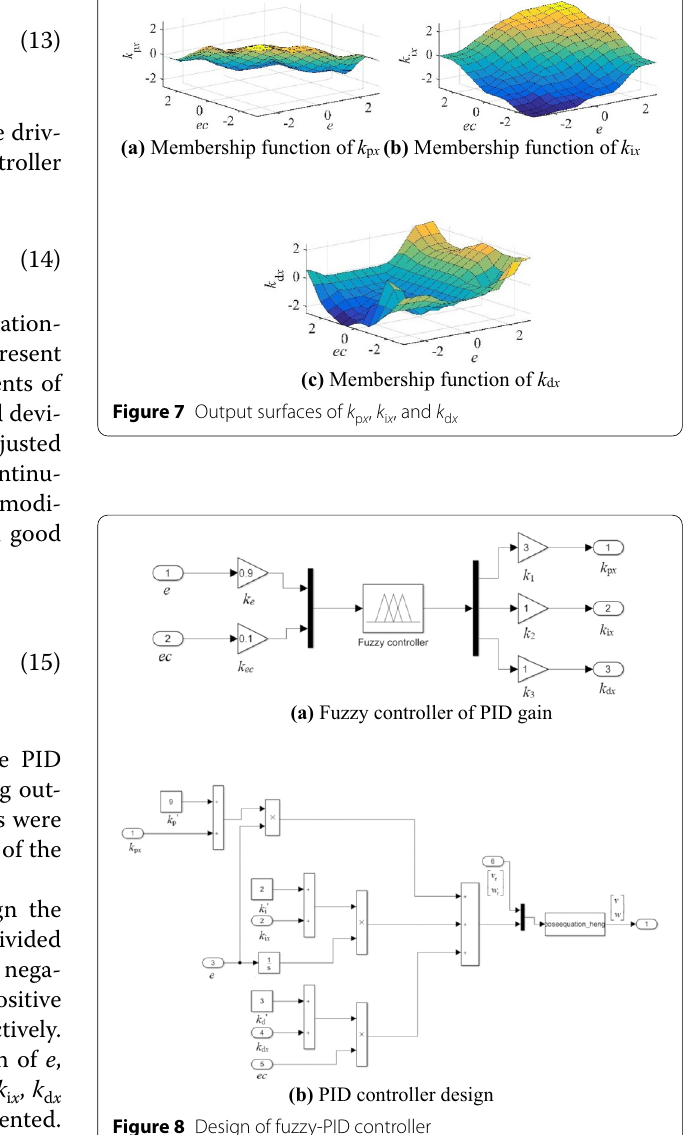
Figure 8 Design of fuzzy-PID